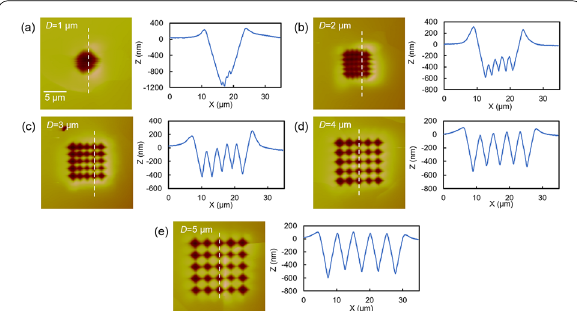
Figure 19 AFM images and the corresponding cross-sections of the experimental results for the 5 5 indentation arrays with the rotation × angle of 0° and the spacings of a 1 μm, b 2 μm, c 3 μm, d 4 μm and